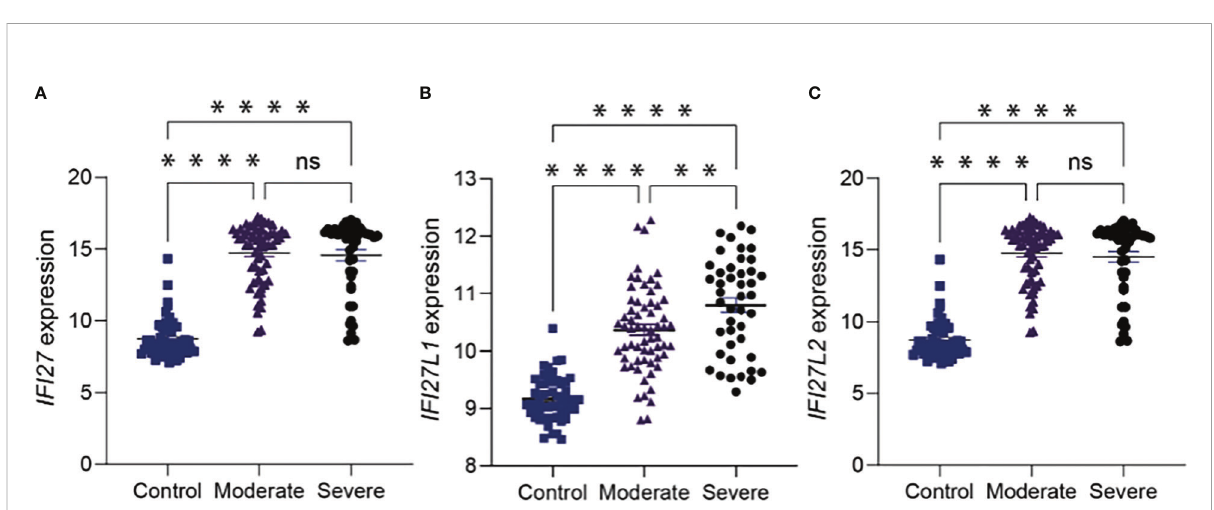
FIGURE 4 (A) IFI27 like genes have prognostic value in in fl uenza virus infection a IFI27 expression in the blood of 107 in fl uenza patients. (B, C) the IFI27 gene family; interferon alpha-inducible protein 27-like protein 1 ( IFI27L1 ) were best suited to discriminating disease outcome in compared to interferon alpha-inducible protein 27-like protein 2 ( IFI27L2 ). ‘ Moderate ’ disease is de fi ned as the presence of in fl uenza in a patient who requires hospitalization. ‘ Severe ’ disease is de fi ned as the presence of in fl uenza in a patient who requires mechanical ventilation in an intensive care